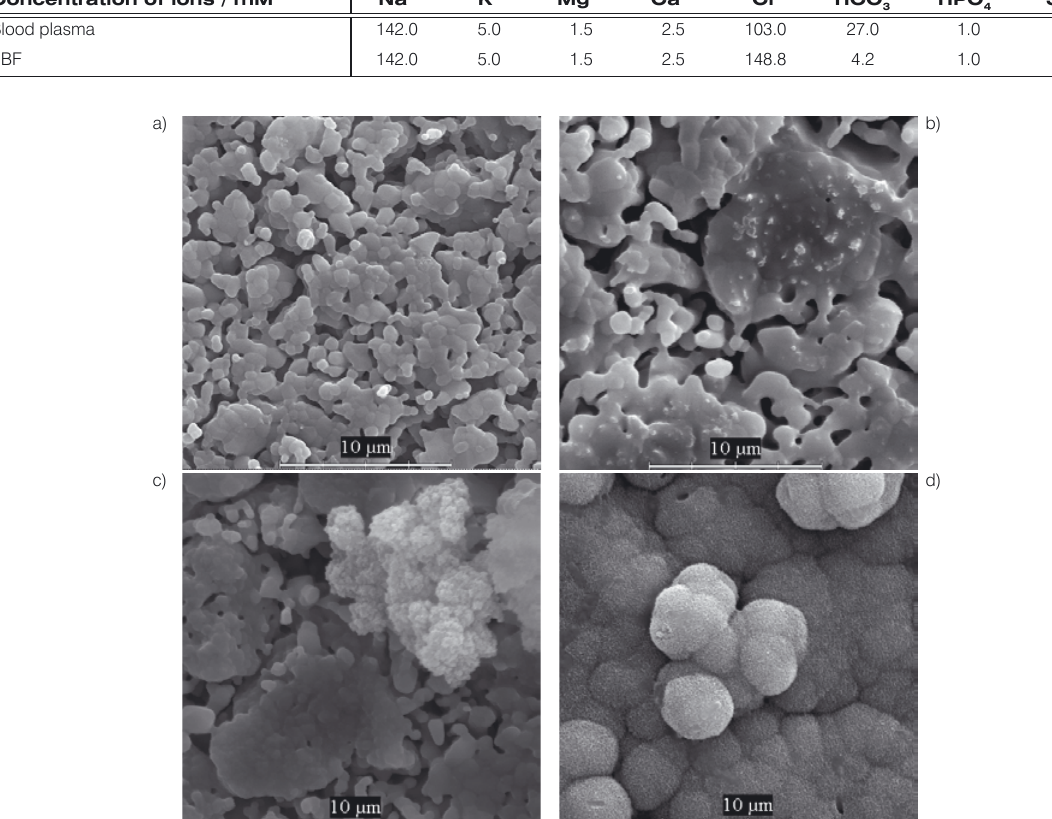
Figure 1. Surface microstructure of HA: a) before immersion in SBF, b) after 48 hours in SBF, c) after 1 week in SBF, d) after 4 weeks in